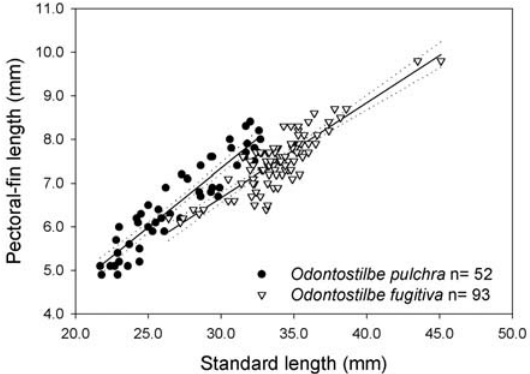
Fig. 5. Snout length as a function of head length for males of Odontostilbe pulchra , against O. splendida , and O. pao